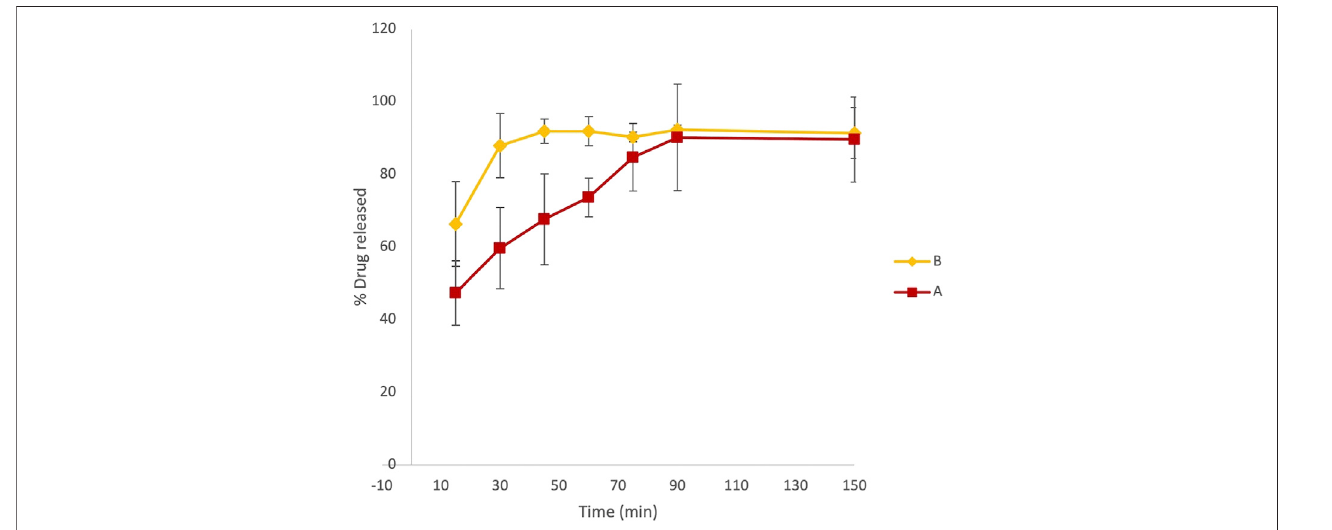
FIGURE3| OverlaidkineticplotsshowingthepercentageofLVNreleasedbyformulationsAandBintime-courseexperiments.Dataarethemeanofsixreplicates. RSD% ranged from 1 to 15%. The graph clearly shows a difference in the dissolution trend for the two tablets.